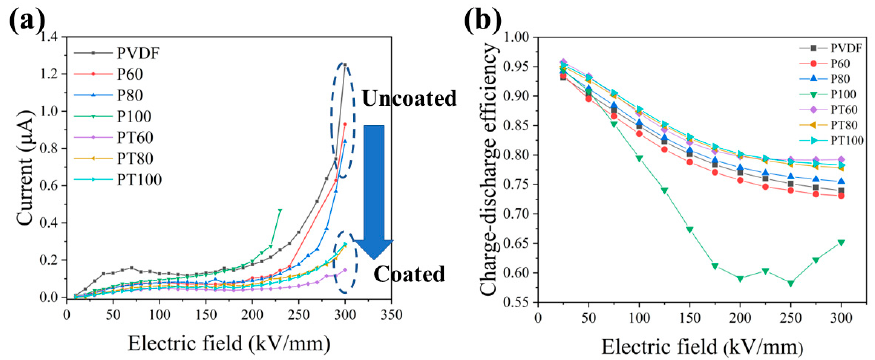
Figure 2. ( a ) Leakage current and ( b ) charge–discharge efficiency of PVDF and PTFE-c-PVDF .